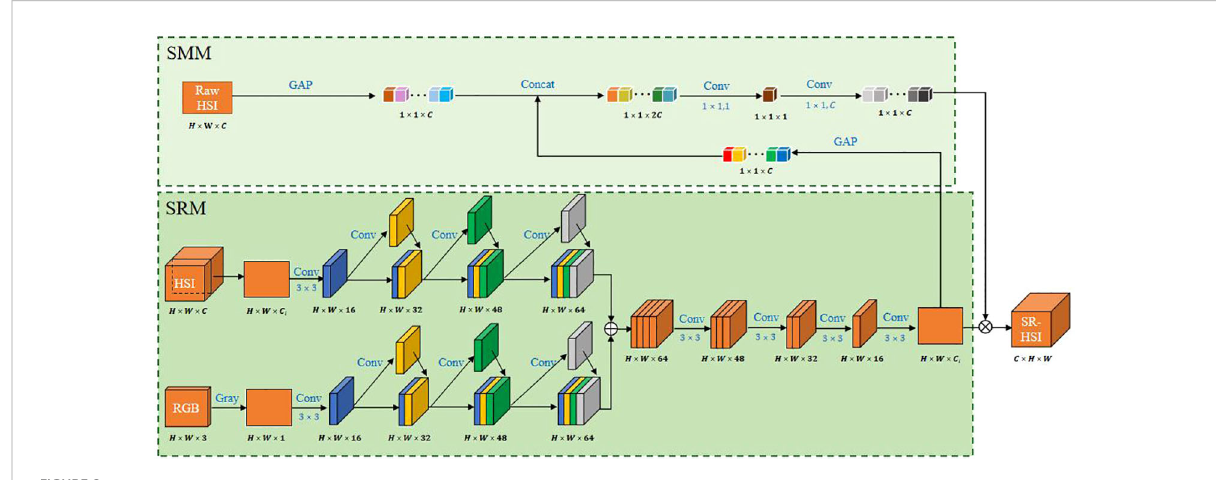
FIGURE 2 Architecture of